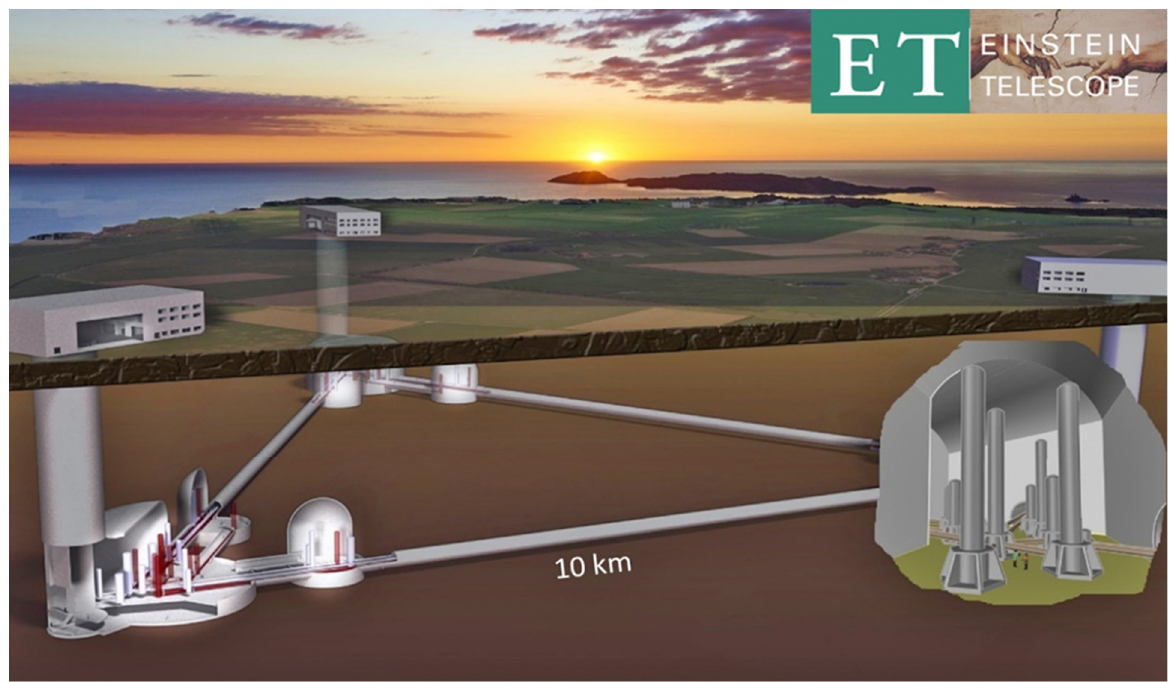
Figure 8. Schematic representation of the Einstein Telescope set up. The final site where it is going to be built has not been chosen yet.